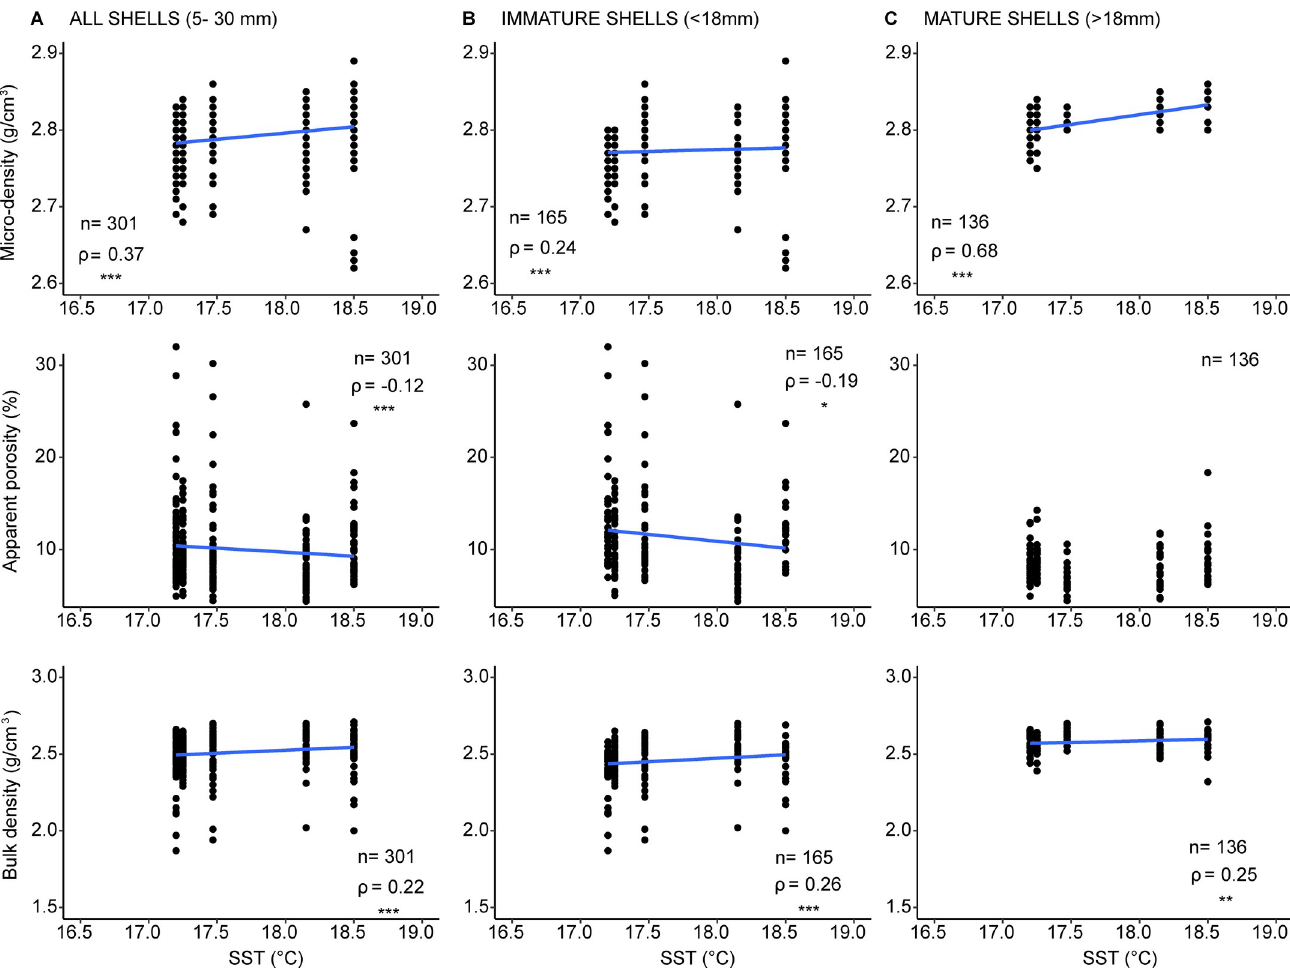
Fig 2. Relationship between shell skeletal parameters and Sea Surface Temperature (SST). (A): whole dataset, (B): immature shells and (C): mature shells. n = total specimens analyzed; ρ = Spearman’s determination coefficient; � p < 0.05; �� p < 0.01; ��� p < 0.001.